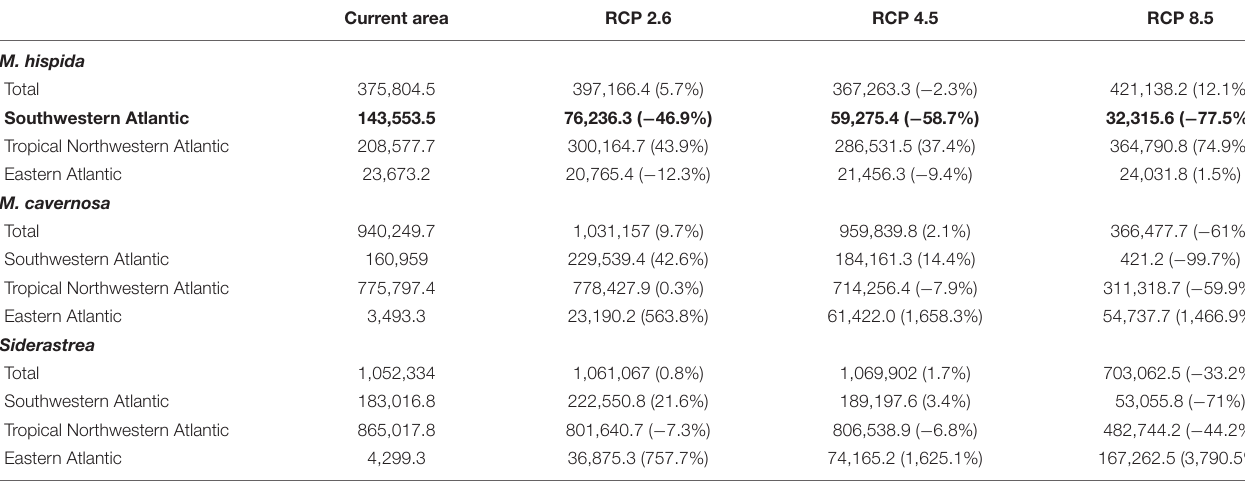
TABLE 3 | Current and future projected areas for three reef builders of the Atlantic obtained through species distribution